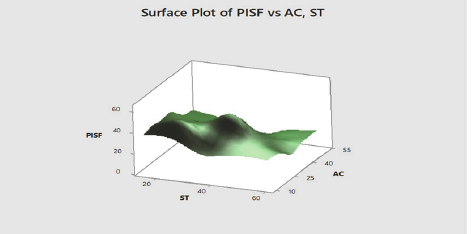
Fig. 1. Surface plot between for PISF vs AC, ST Fig. 2. Surface plot between for PISF vs CP, AC